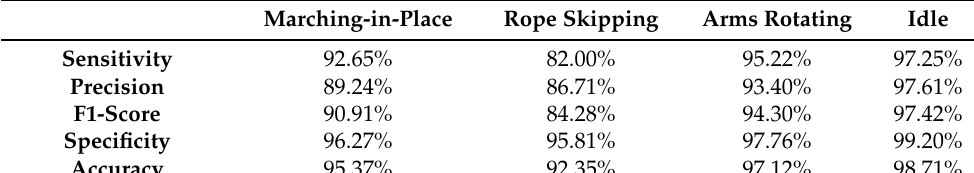
Table 2. The sensitivity, precision, F1-score, specificity and accuracy of the classification via the RF. Marching-in-Place